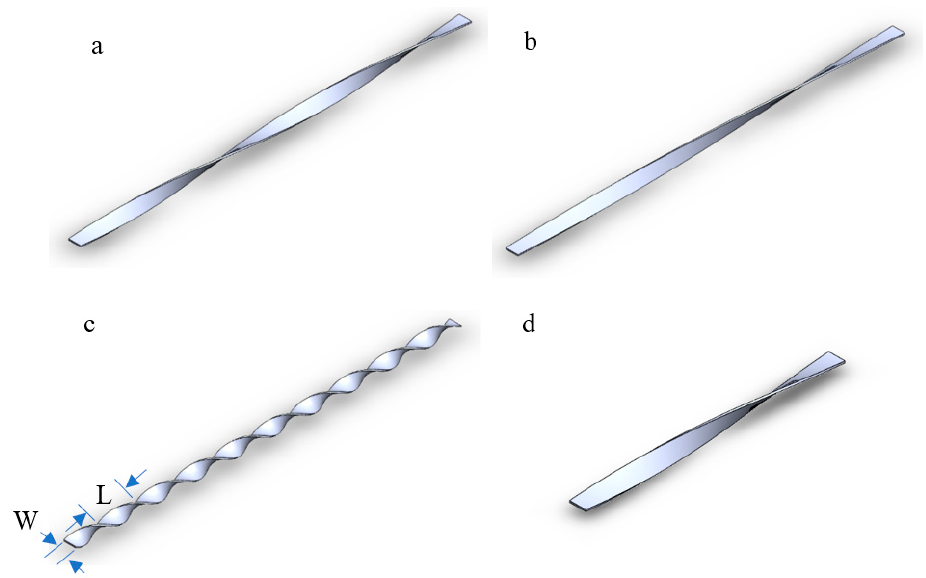
Figure 2. ( a ) Full twist twisted tape, ( b ) half-twist twisted tape, ( c ) twisted tape with twist ratio of 3 and ( d ) half-length twisted tape.